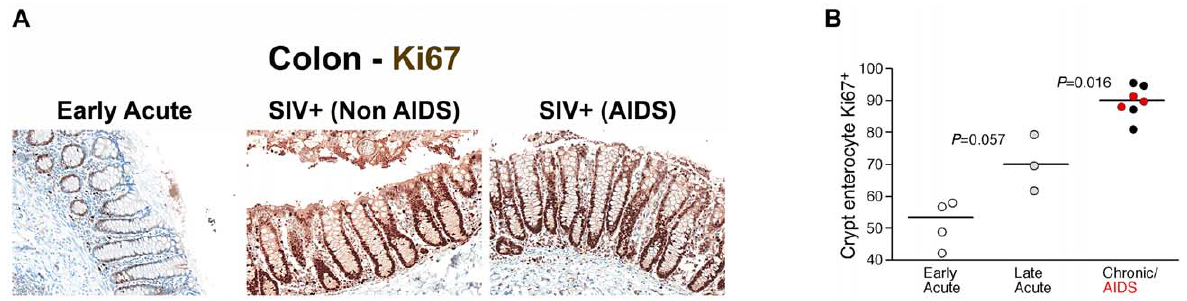
Figure 9. Damage to the integrity of the epithelial barrier is associated with increased enterocyte proliferation. ( A ) Representative images (200 6 ) of colon stained for the proliferative nuclear protein Ki67 (brown). Note progressive change in frequency and location of Ki67 + enterocytes, from few cells at the base of crypts during early acute infection (4 dpi), with full involvement of crypts with proliferating cells in chronically infected Non-AIDS and AIDS animals. ( B ) Quantitative image analysis of Ki67 expression by colonic enterocytes in early acute (white circles), late acute (gray circles), chronic Non-AIDS (black circles) and chronic AIDS (red circles) RMs demonstrates the statistically significant increase in enterocyte proliferation in chronic infection. Mann-Whitney U test performed between the chronically infected (both Non-AIDS and AIDS) and late acute RMs and between early acute and late acute RMs.